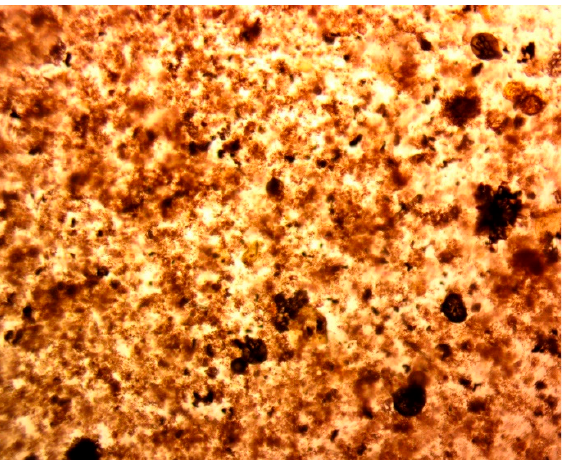
Figure A1. Settled entrained hydrated polymer formed by the sol-gel approach (Example A1a); Transmitted light, Field of view 1 mm. Transmitted light, Field of view 1